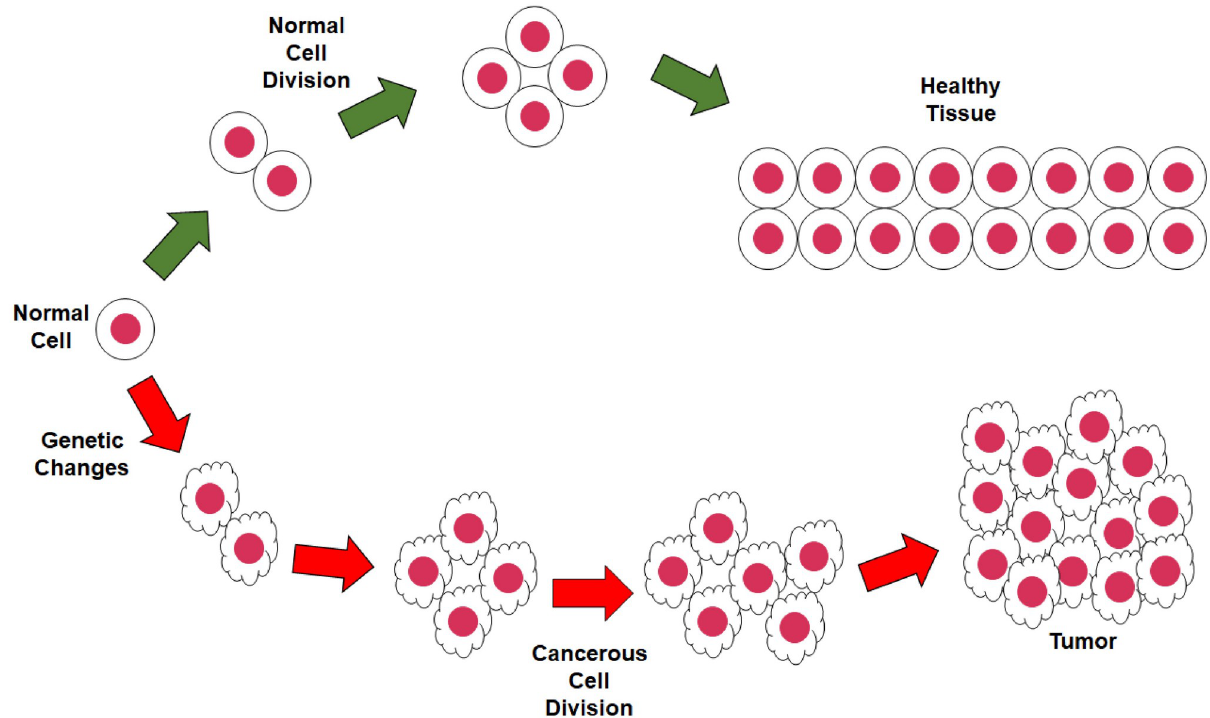
Fig 1. Sample image of brain